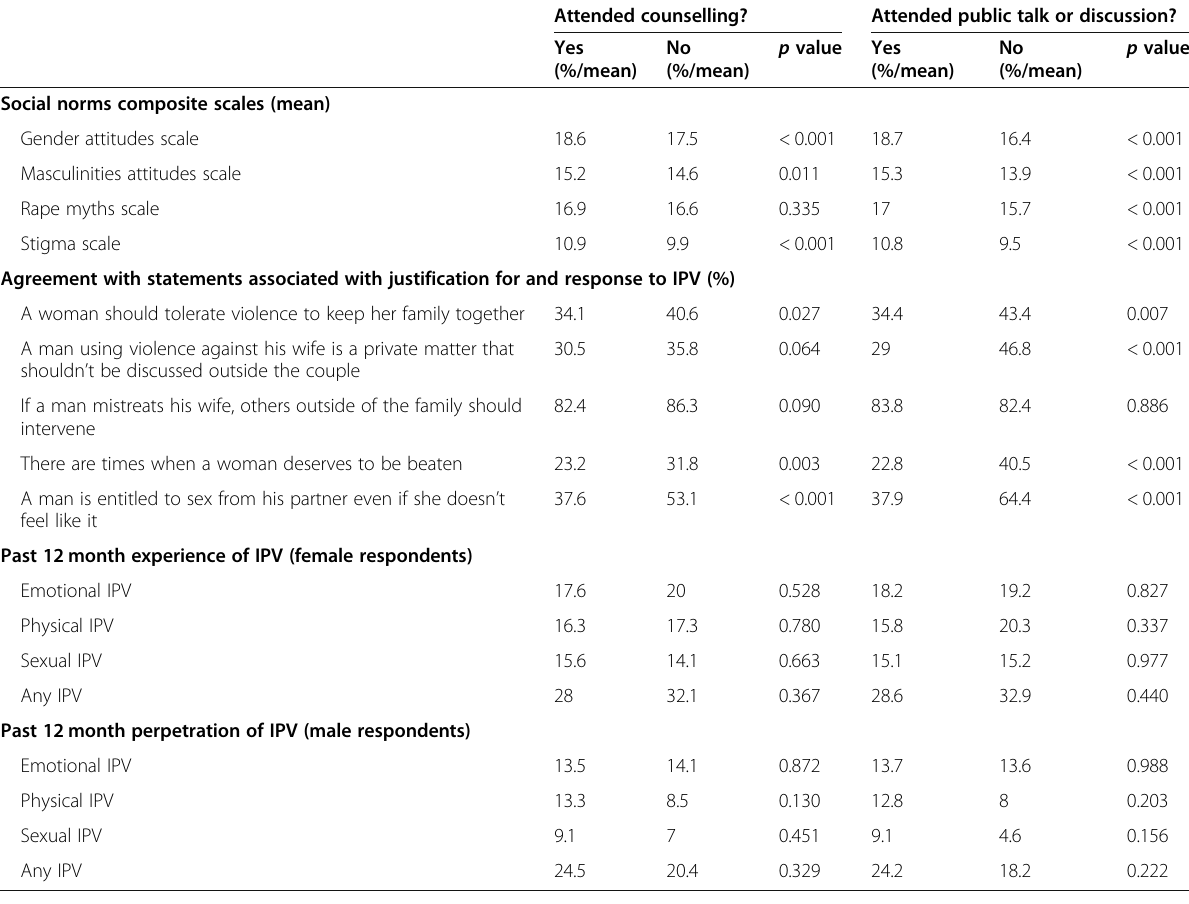
Table 8 Endline results for social norms, attitudes and experience and perpatration of IPV, disaggregated by exposure to intervention